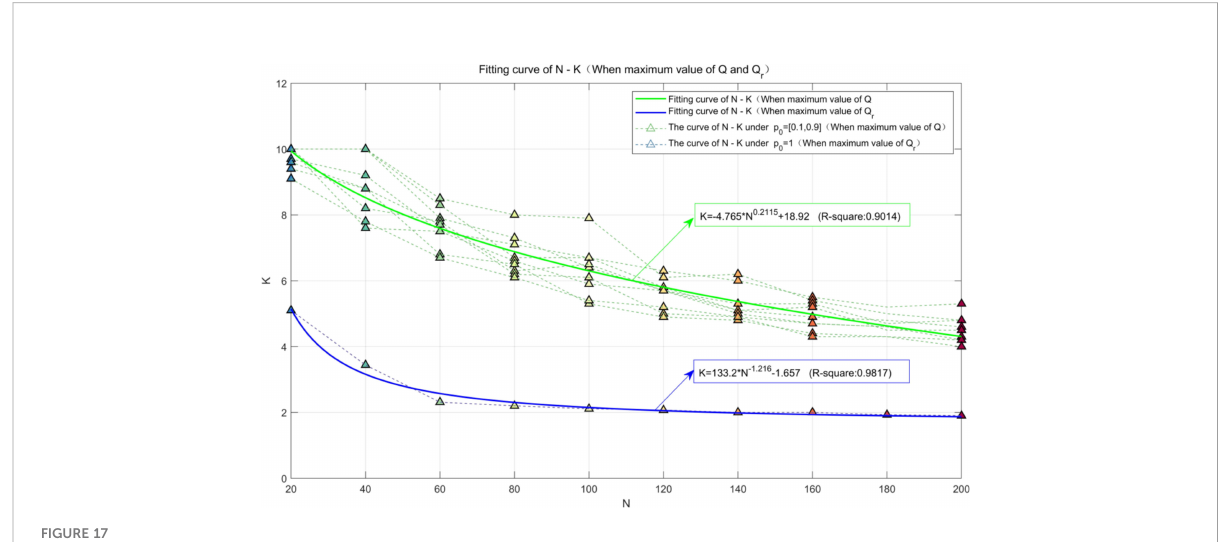
FIGURE 17 In fl uence of N on K when Q or Q r is the maximum value.